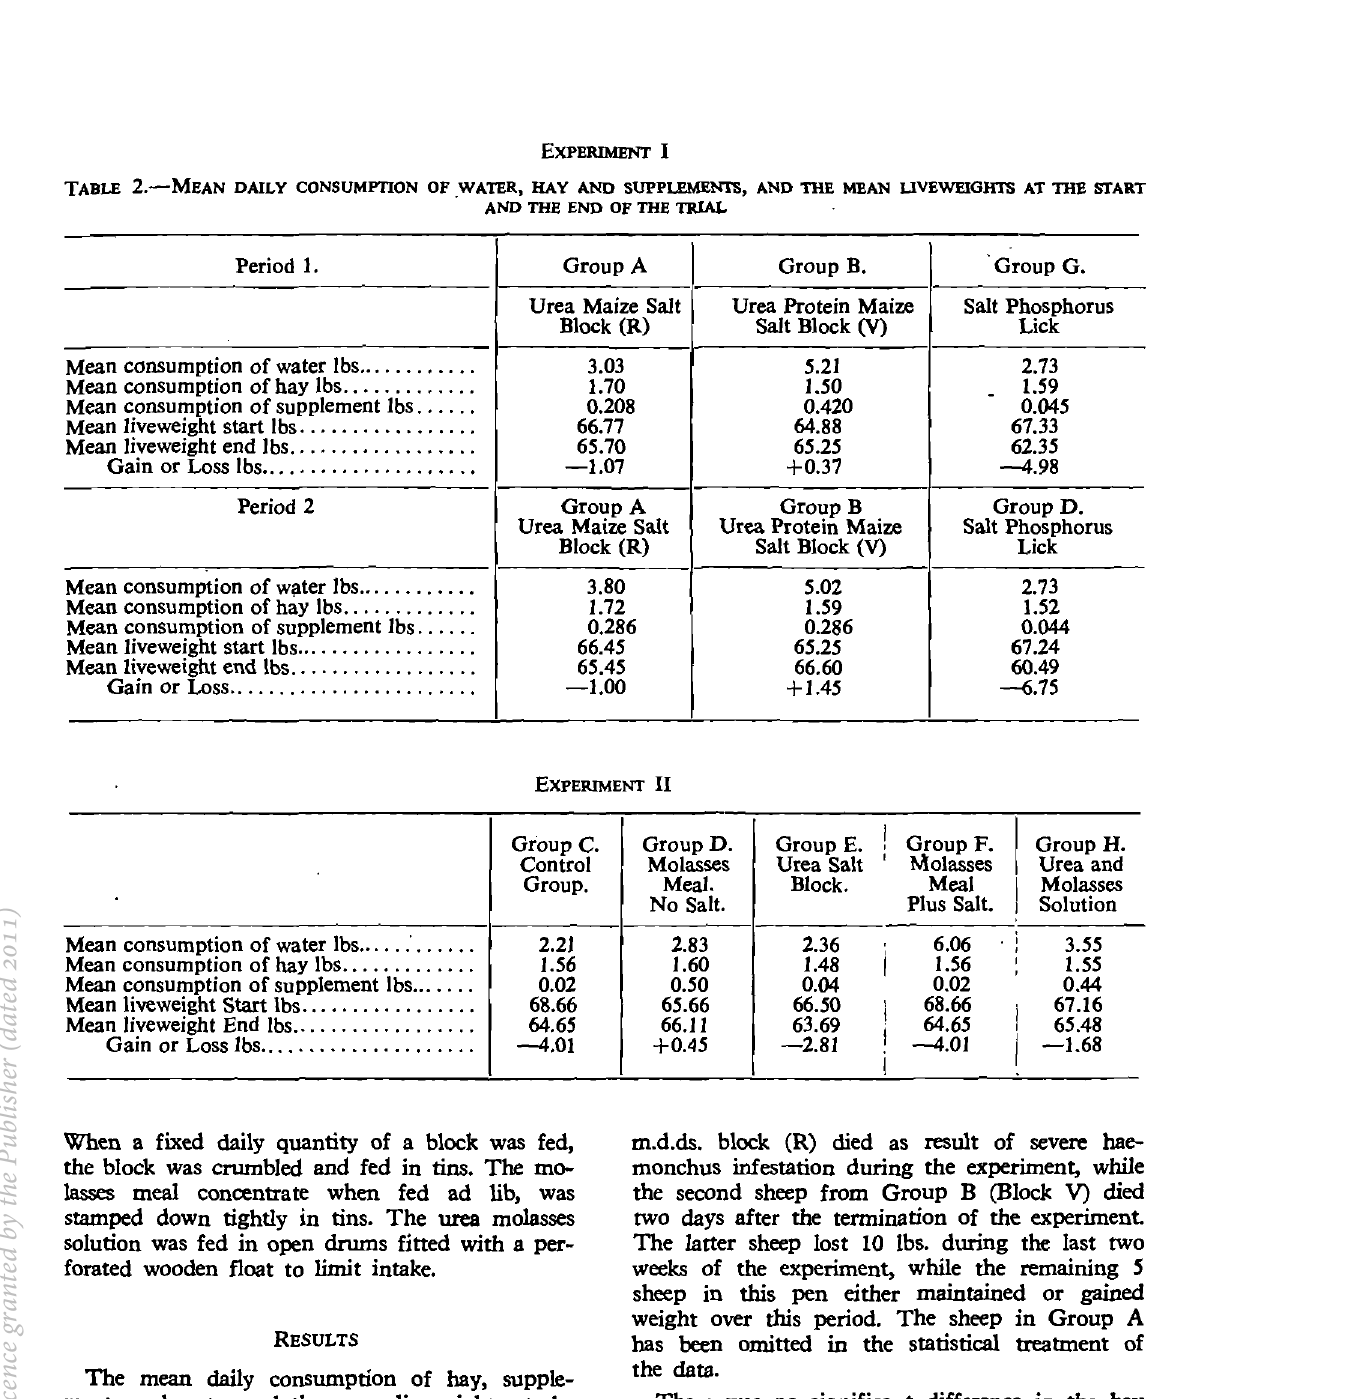
TABLE 2.-MIlAN DAILY CONSUMPIlON OF WATIlR, HAY AND SUPPLEMIlNTS, AND THE MilAN UVIlW1!IGHTS AT THE START . AND THE END OF THE TRIAL Period